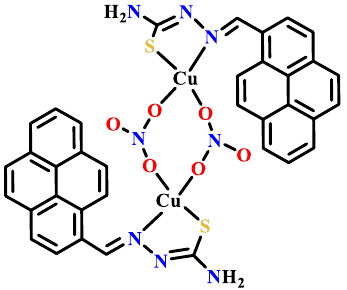
Figure 50. Binuclear copper(II) complex of pyrene hydrazone ligand with thiourea as a side chain bridged by two nitrate co-ligands.